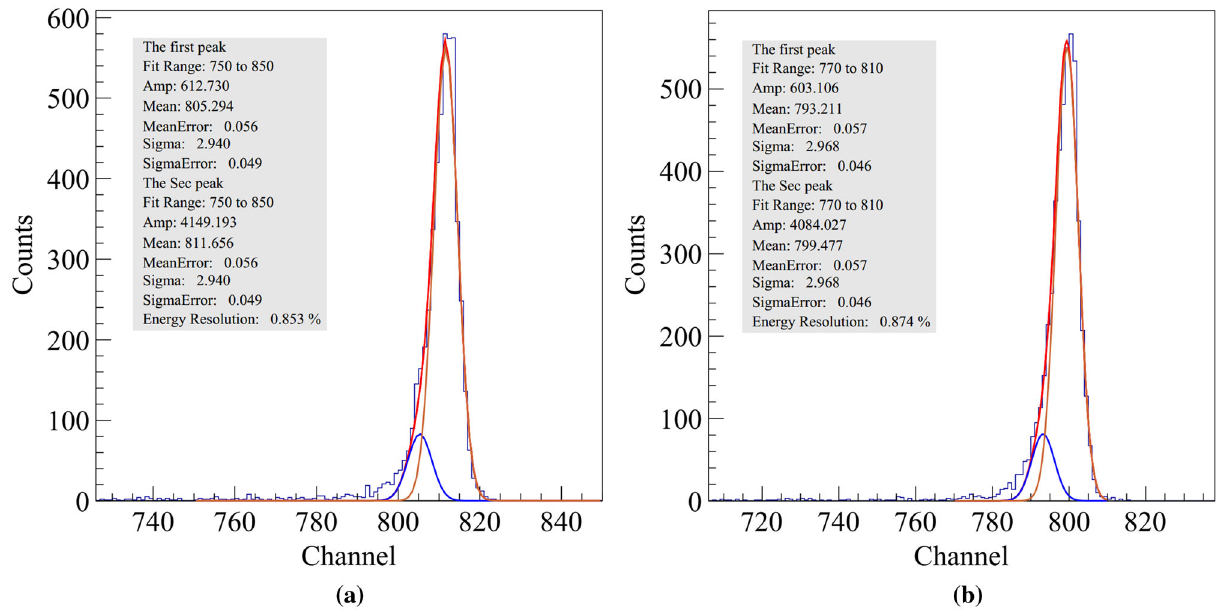
Fig. 4 The energy spectra from the two identical measurements, with 0.5 ( a ) and 0.7 mm ( b ) collimation holes